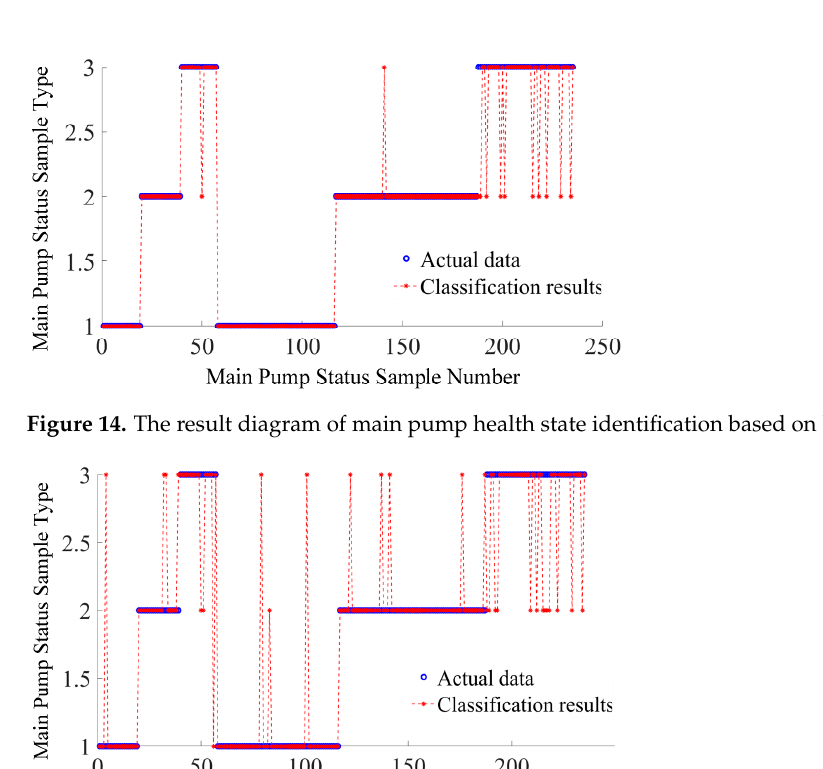
Figure 13. The result diagram of main pump health state identification based on EEMD-OQGA- SVM.